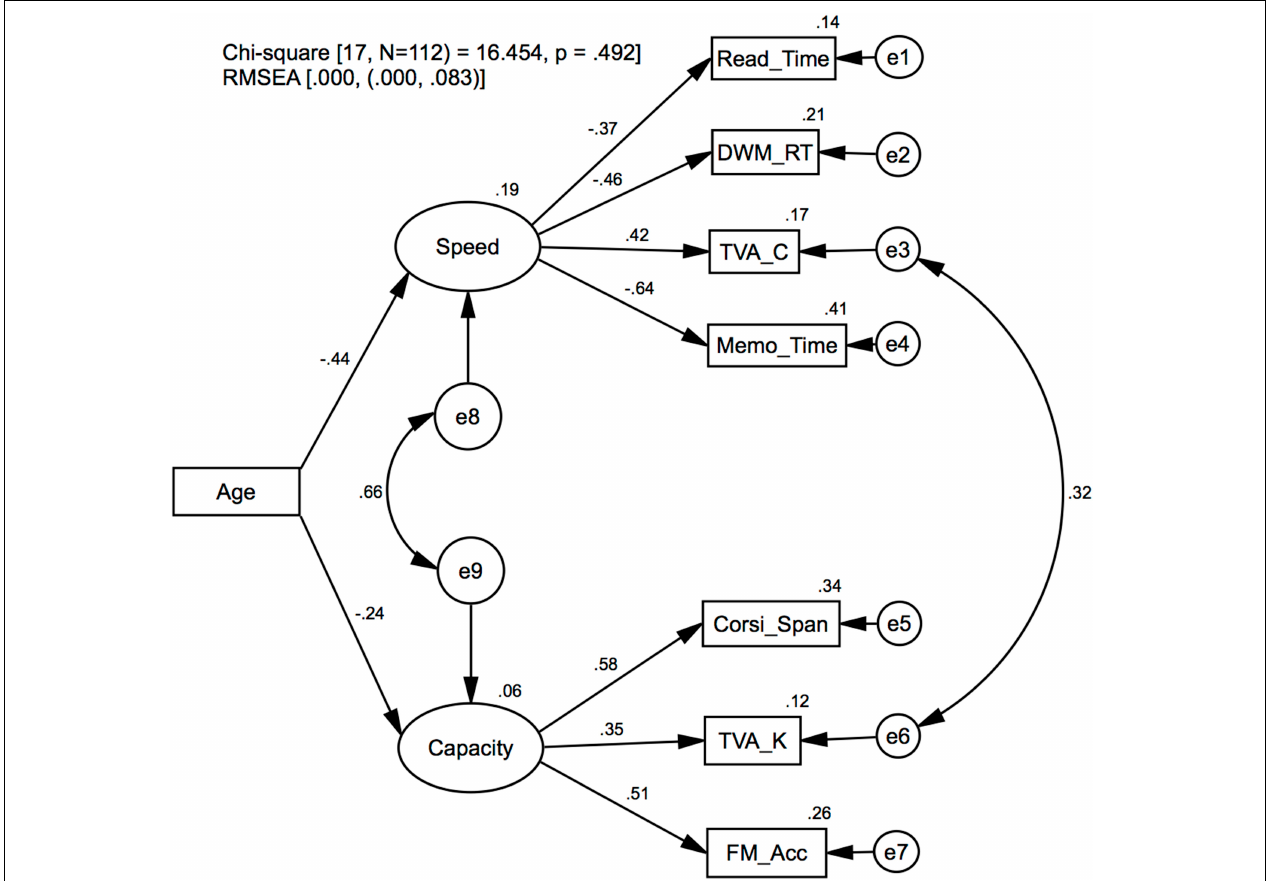
FIGURE 2 | Model 2: Confirmatory factor analysis. Latent variables for processing speed (Speed) and VSTM capacity (Capacity), and the regression of age on these. Standardized regression weights